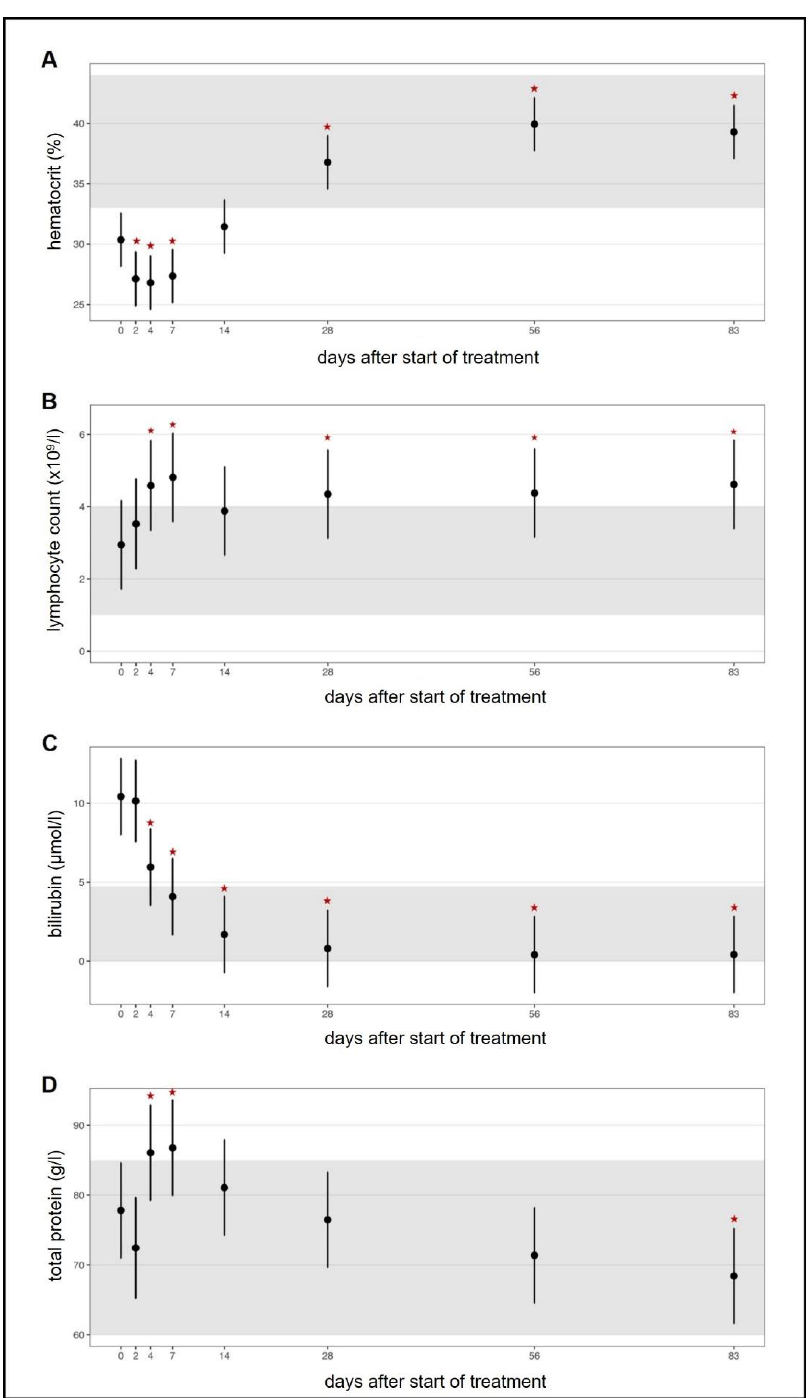
Figure 4.1 Figure 4. Cont